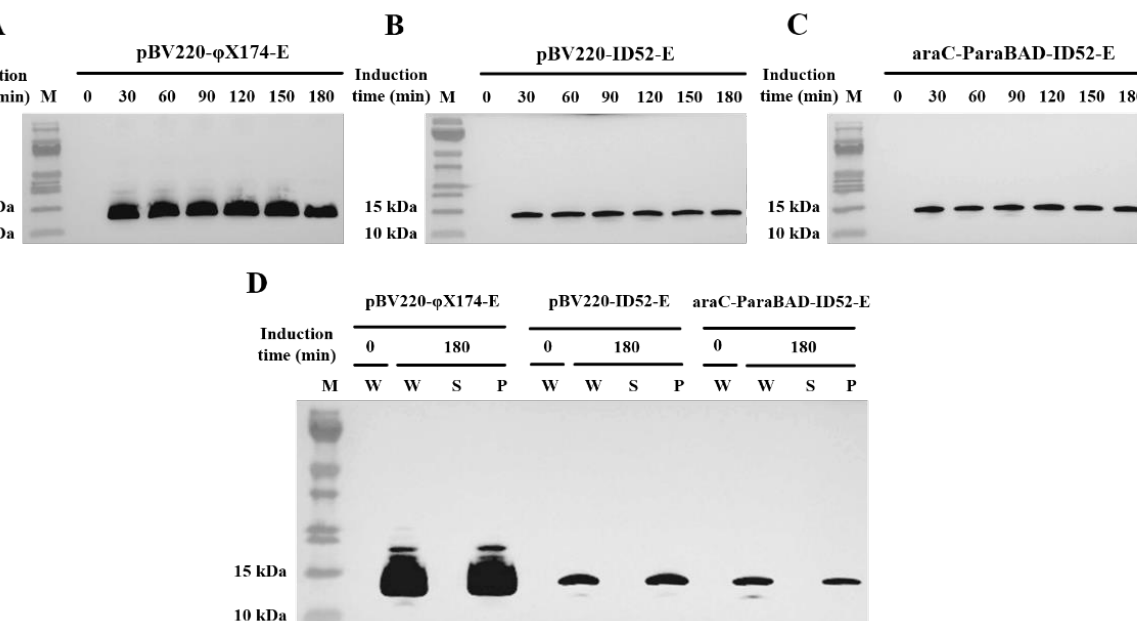
Figure 5. The expression levels and expression location of lysis protein E at different induction times were detected by Western blot. ( A – C ): The whole lysis solution of E. coli BL21(DE3) harboring pBV220- ϕ X174-E, pBV220-ID52-E and araC-ParaBAD-ID52-E plasmid, respectively; ( D ) The expression location of lysis protein E. M: 26616 prestained protein marker, W: whole lysis solution; S: supernatant; P: precipitate.